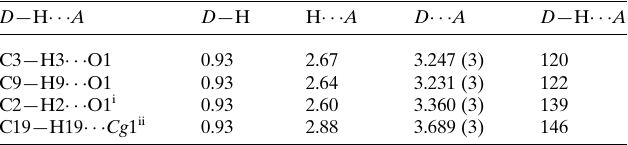
Table 1 Hydrogen-bond geometry (A˚ , (cid:2) ). Cg 1 is the centroid of the C1–C6 ring.